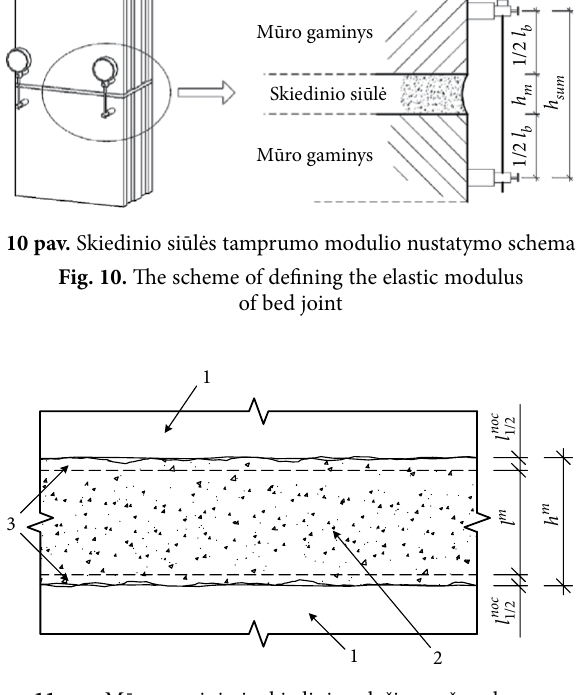
Fig. 11. The scheme of bed joint: 1 – unit; 2 – mortar